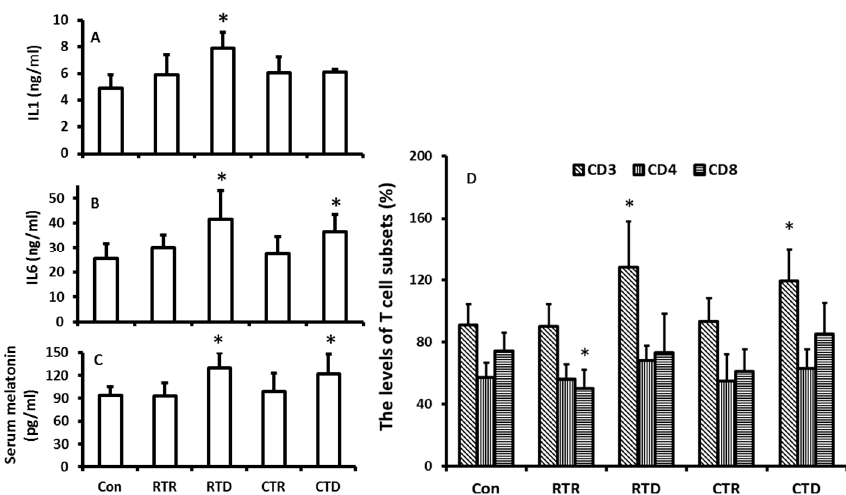
Figure 4. Temperature changes on the melatonin production and immuno-responses of hamsters. The animals were housed in the fixed ligh/dark cycle (12/12 h) and humidity but different temperature patterns. Con: 22 ± 2 °C; RTR: rapid temperature rising; RTD: rapid temperature drop; CTR: constant temperature rising and CTD: constant temperature drop, respectively. Animal were sacrificed after 72 h of the treatments at 9–10:00 pm under dim red light. Serum was collected for the further assays. A and B : the levels of IL1 and 6, respectively; C : the serum melatonin level, D : the distributions of CD3, 4 and 8 in different treatment groups. The data were expressed as means ± SDs of eight hamsters each group. * Significant difference vs. controls.